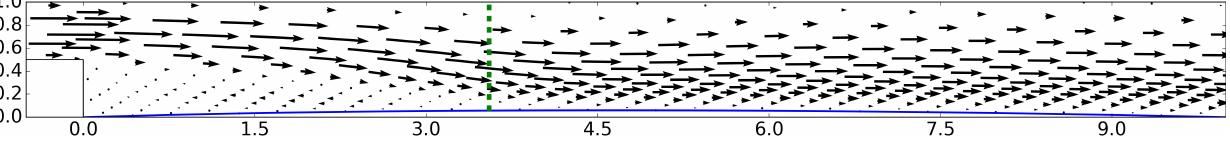
Figure 2. The backward facing step under steady inflow, with control portion l = 10 of elastic membrane bottom wall with T m = 55 and p e = 0.525, for − 0.5 ≤ x ≤ 10. The maximum membrane displacement arrow emerges at x = 4.655 and has the value g ( x = 4.655 ) = 0.06. Reattachment of the flow occurs at x = 3.55 (indicated by the dashed line).